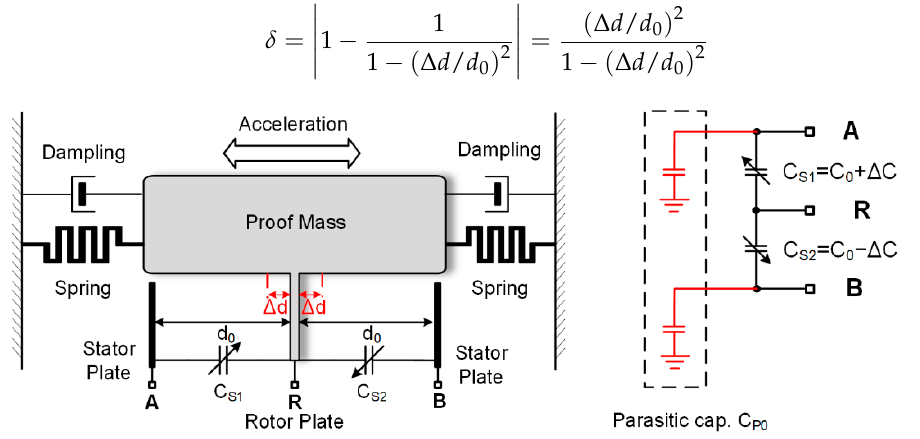
Figure 1. Sensing element of a typical MEMS capacitive accelerometer.